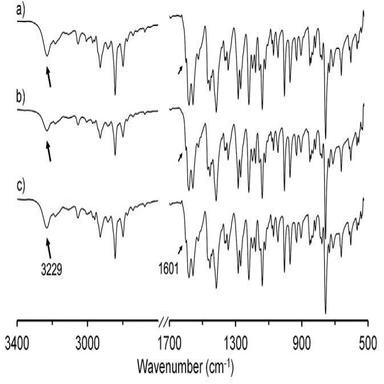
Middle infrared spectra of OLZ A (a), B (b) and C (c).